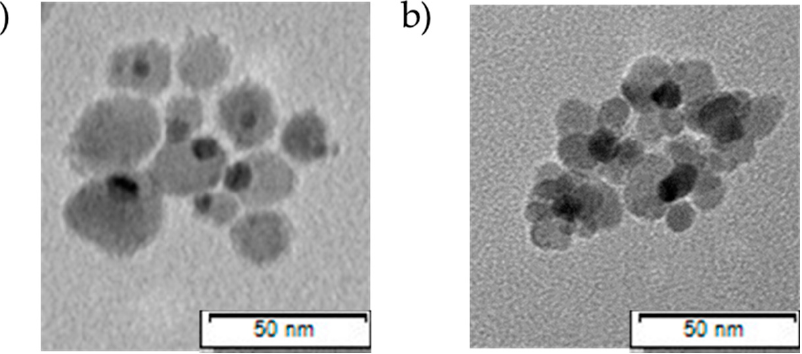
Figure 3. Representative TEM micrographs illustrating iron–gold nanostructures: ( a ) nanodumbbells, ( b ) nanoflowers taken from Kayser et al. (unpublished).